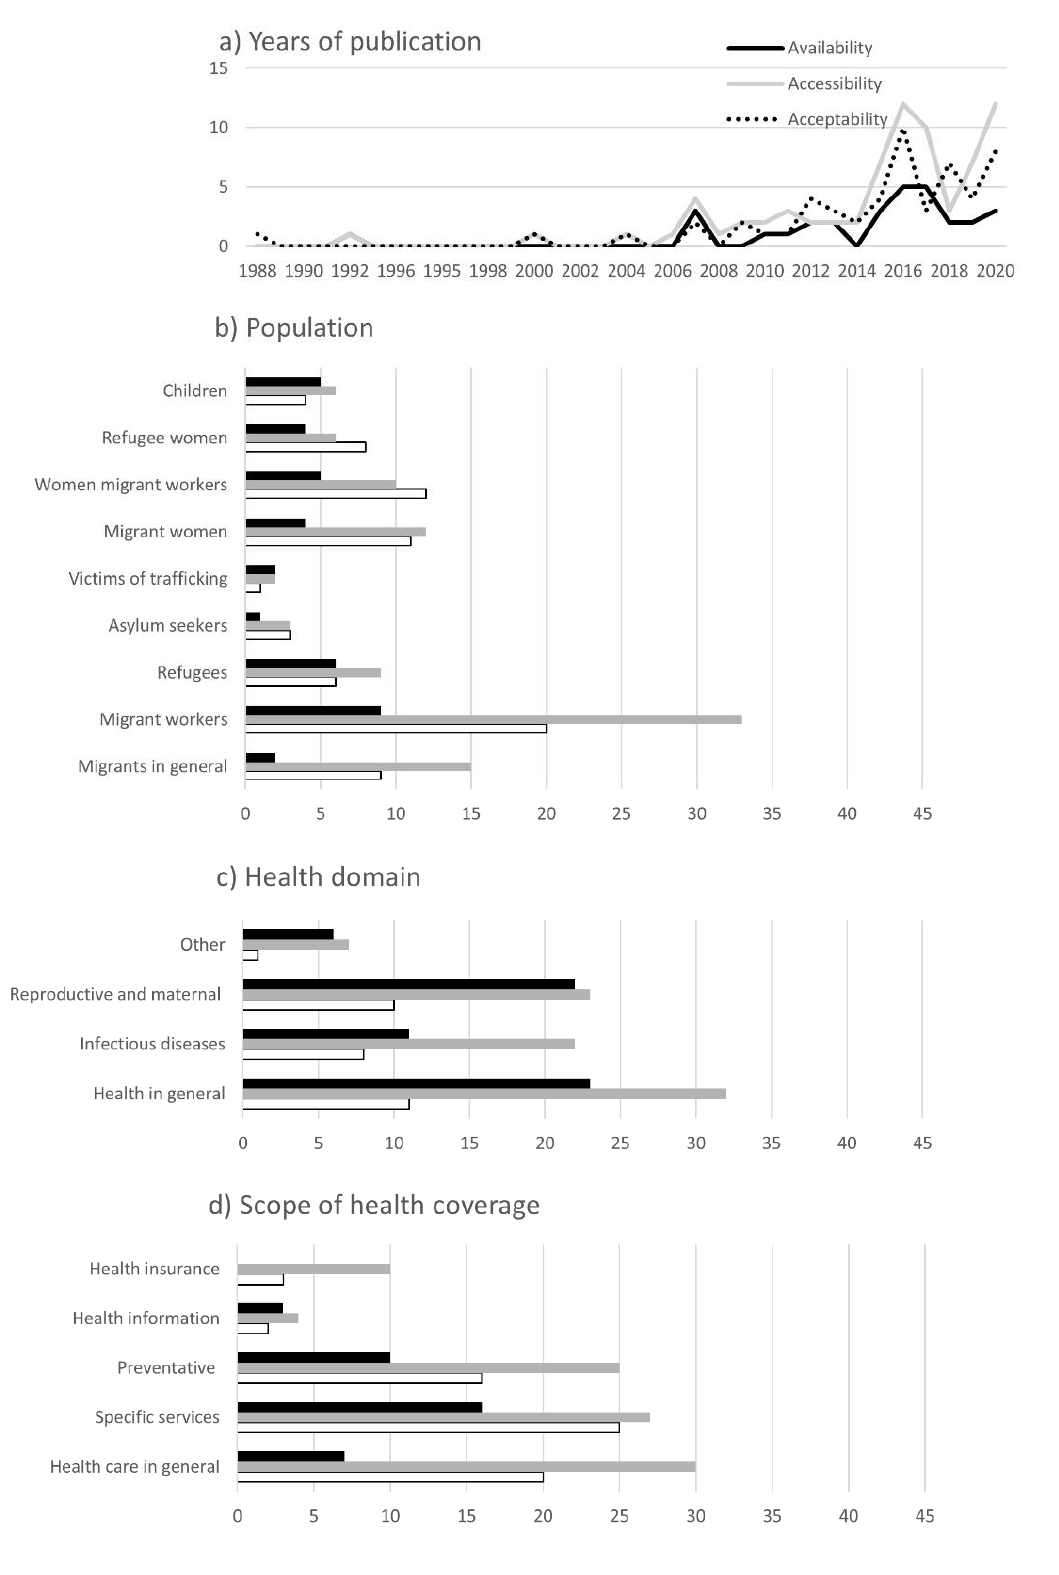
Figure 2. Charts of synthesised data items, including ( a ) years of publication (x-axis = year, y-axis = number of articles), ( b ) type of migrant population, ( c ) health domain and ( d ) scope of coverage. (x-axis = number of articles, availability = black, accessibility = grey, acceptability = white).